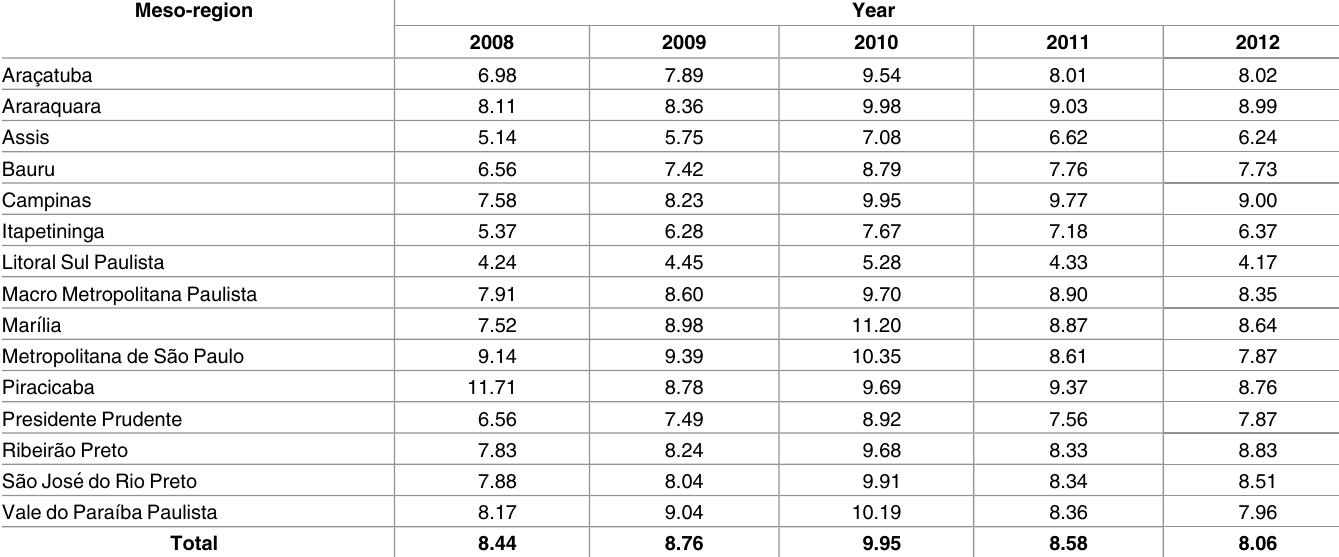
Table 1. Annual oral antibiotic consumption in S ã o Paulo and its meso-regions, by DID * .